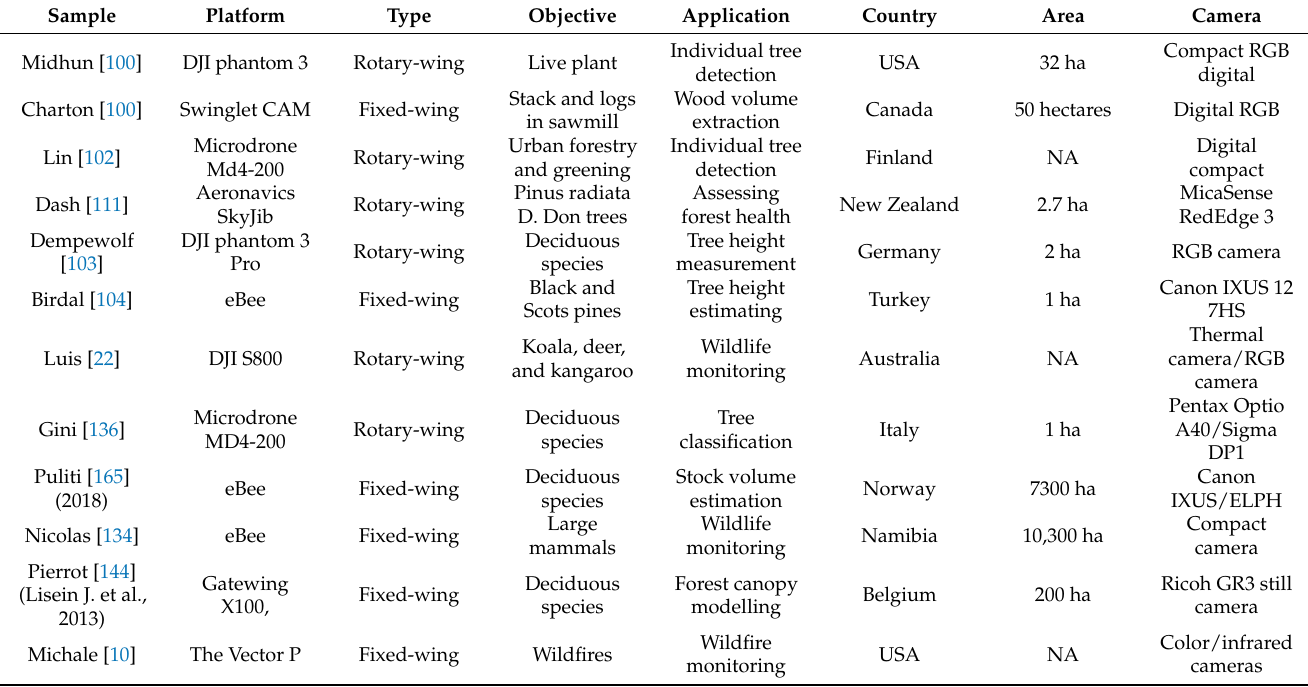
Table 6. UAVs samples used for forestry applications (NA: Not